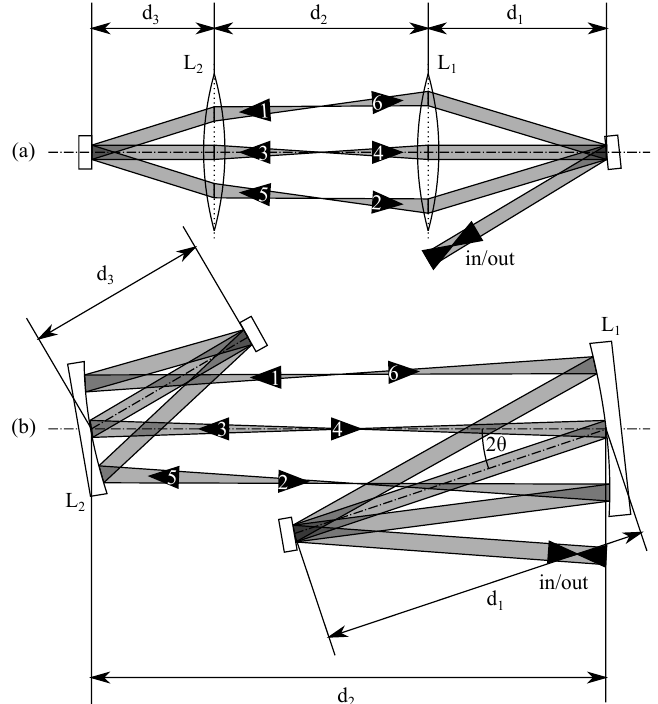
Figure 1. Schematic drawings of Type I systems with three round-trips based on lenses ( a ) and on mirrors ( b ) as imaging elements. The numbers in the arrows denote the sequence of passing